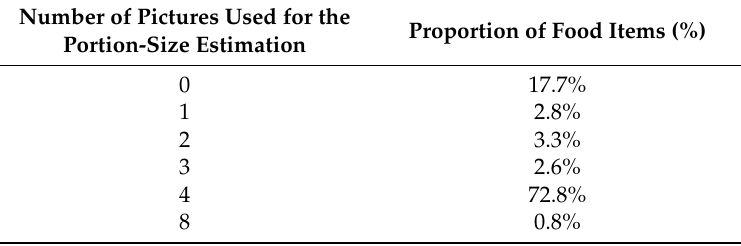
Table 1. Distribution of the food items according to the number of pictures used for the portion-size